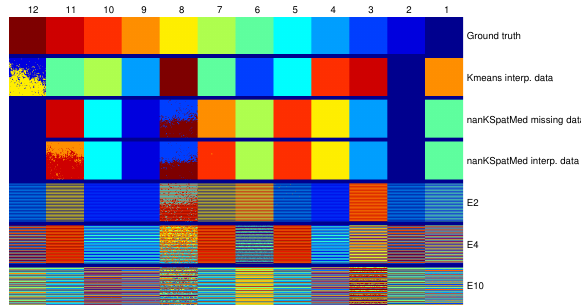
Figure 5. Clustering results for different data sets and methods using 12 subsets from each